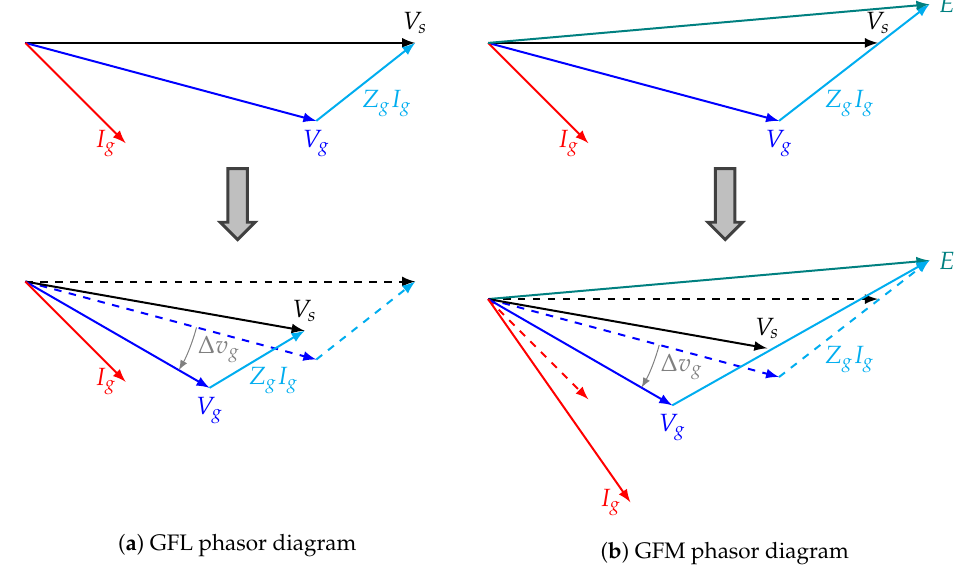
Figure 8. Phasor relations of GFM and GFL converters due to grid voltage